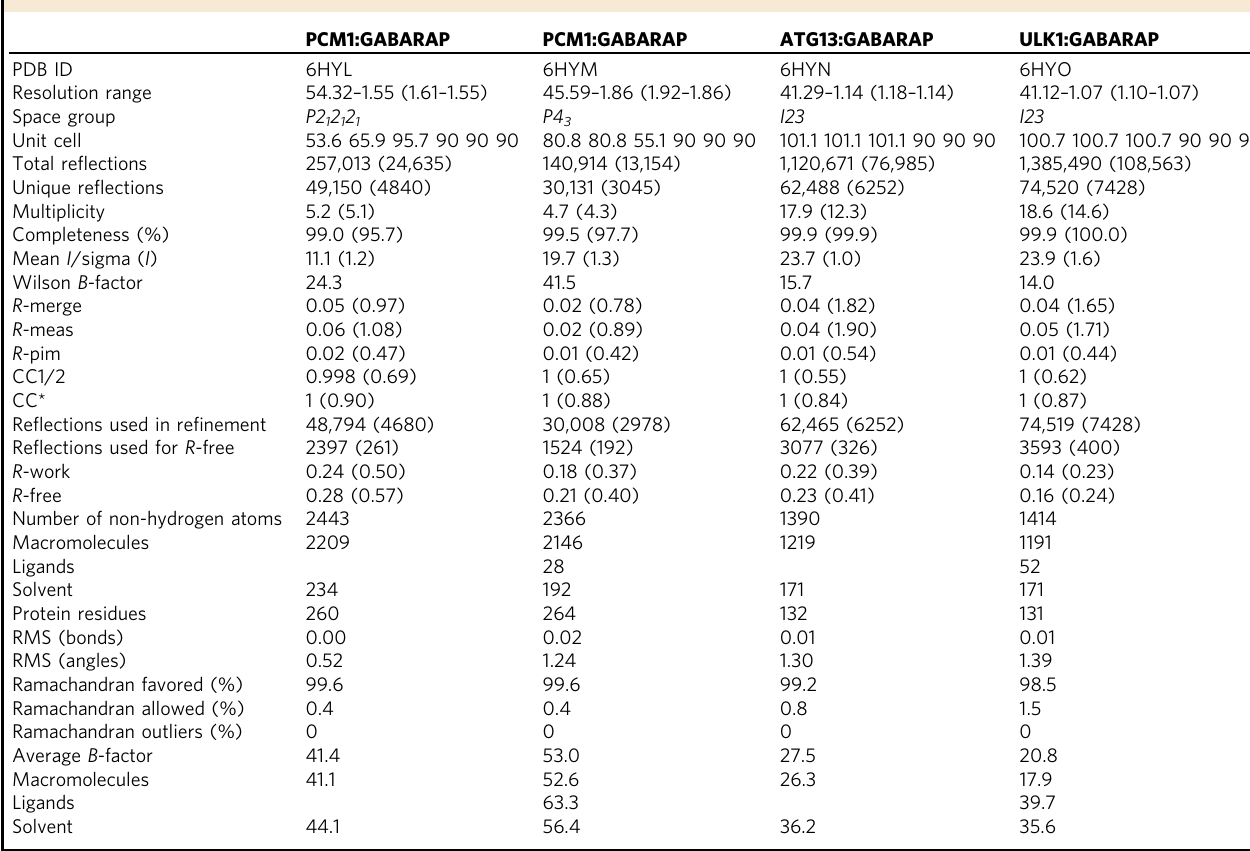
Table 1 Data collection and re fi nement